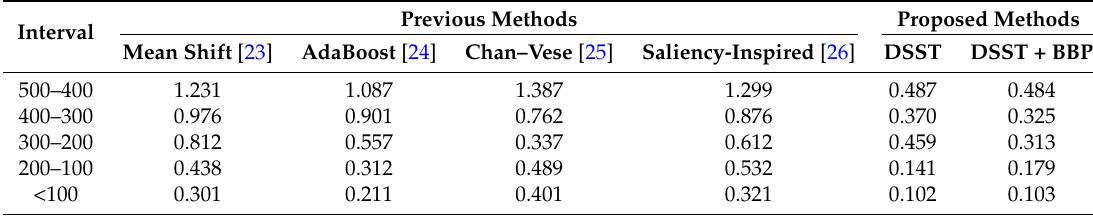
Table 9. Errors (m) in the k O , c -axis with tracking algorithms at separate intervals (m).